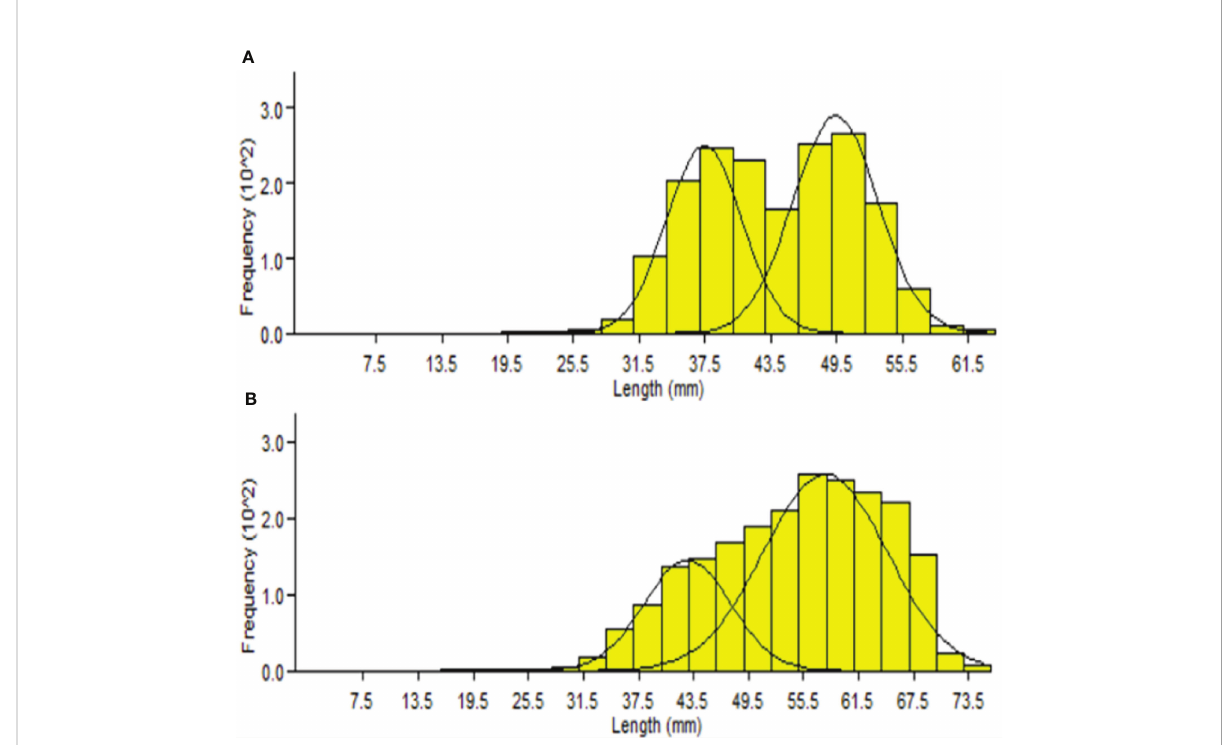
FIGURE 10 Cohort analysis output from FiSAT II for (A) male and (B) female P. adspersus from the southeast Caspian Sea (2019 – 2020).